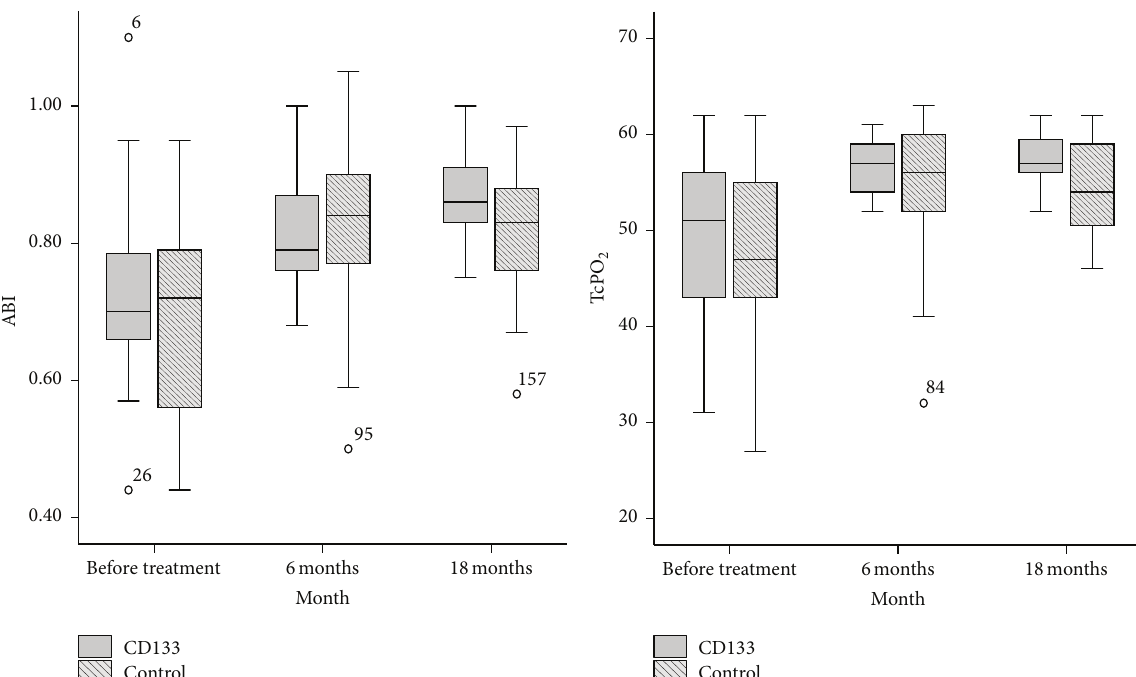
Figure 2: ABI and TcPO 2 difference before and after treatment. TcPO 2 and ABI were improved significantly in CD133 + group than control at 18 months and did not improve at 1 month, indicating a delayed and persistent perfusion-improving benefit of CD133 + progenitor cell treatment. “ ∘ ” represents mild outliers in boxplot, and the small numbers beside it represent the case numbers.